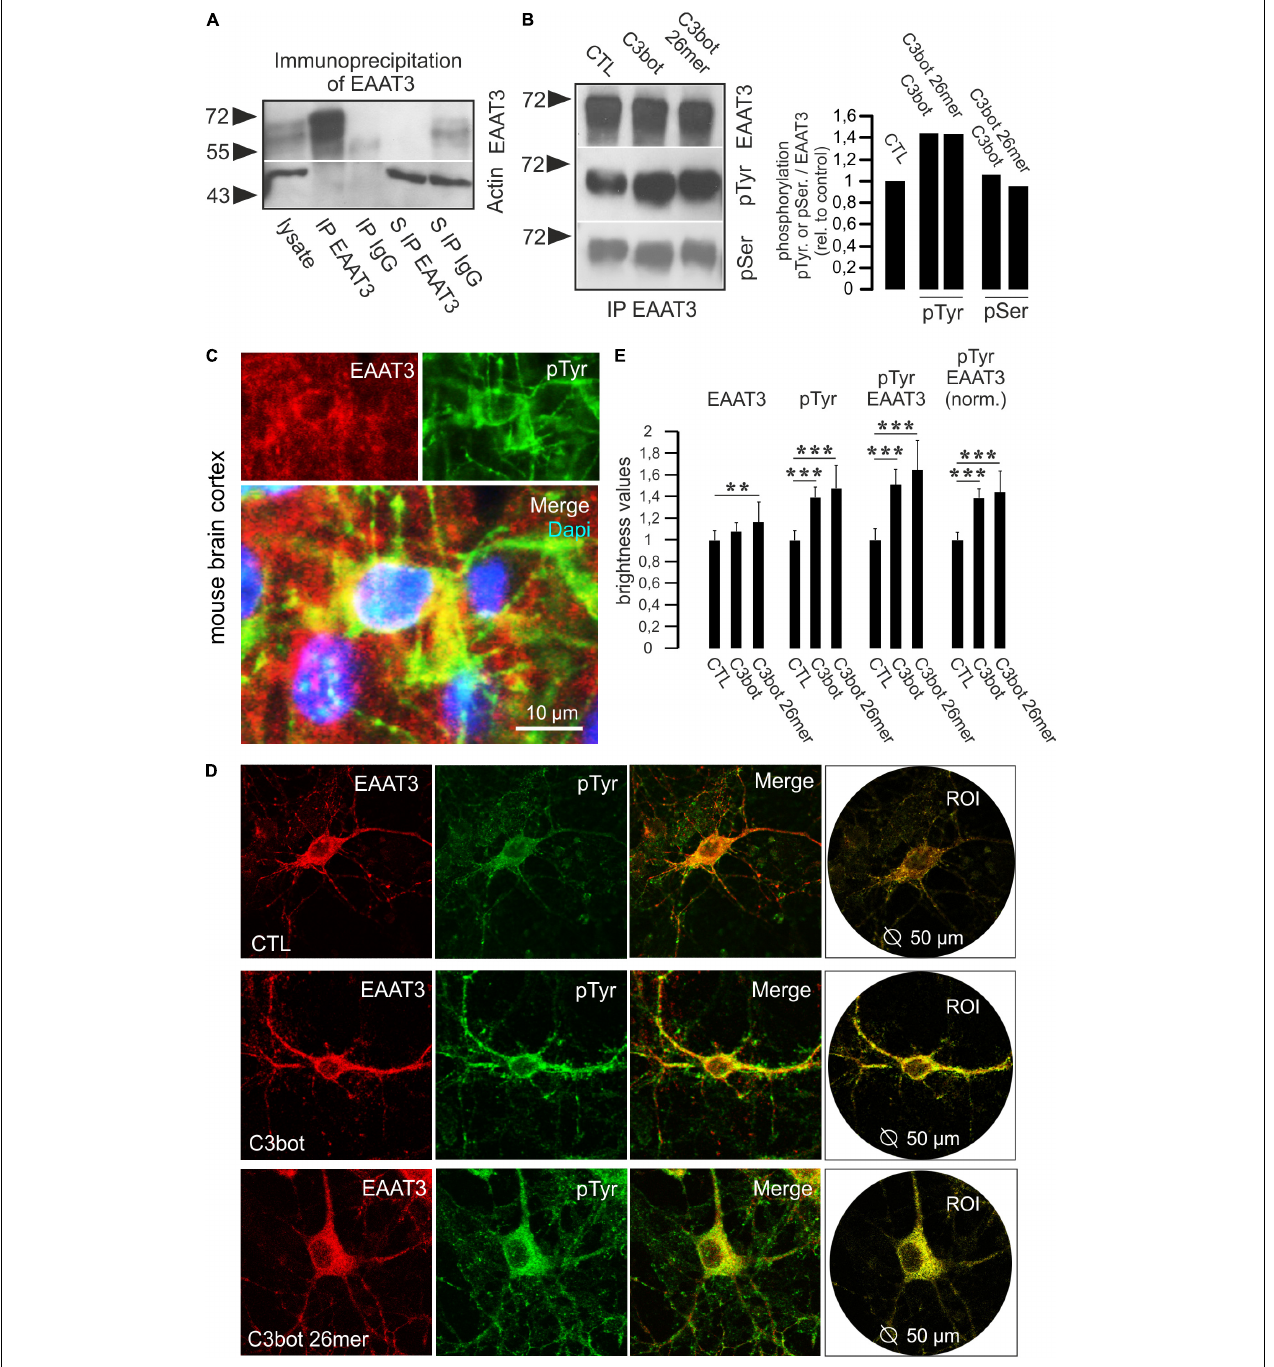
FIGURE 5 | Phosphorylation at tyrosine residues of EAAT3 is mediated by C3bot and 26mer. (A) Immunoprecipitation of EAAT3 from hippocampal cell lysates. Hippocampal neurons were lysed and subjected to immunoisolation of EAAT3. Lysates, precipitated fractions and remaining supernatants were probed for EAAT3 expression. Beads coated with rabbit IgG were used for negative control. Actin staining was used for loading control. For detection, light chain-specific secondary antibodies were applied to prevent unwanted detection of heavy chains of the precipitating polyclonal EAAT3 antibody. In the EAAT3 immunoprecipitates (IP) a strong transporter signal was detectable confirming precipitation of transporter by the antibody. In the rabbit IgG fraction no transporter signal was detectable. Clearance of the lysate from the EAAT3 signal following immunoisolation of EAAT3 (supernatant S IP EAAT3) confirmed proper assay function. (B) Hippocampal neurons were treated with 300 nM of C3bot or C3bot 26mer for 3 days. Immunoisolates were probed for EAAT3 and phosphorylation of the transporter at tyrosine and serine residues (pTyr, pSer) by phosphor-specific antibodies. Signals were quantified by calculating the ratio of phosphorylation signals to transporter expression